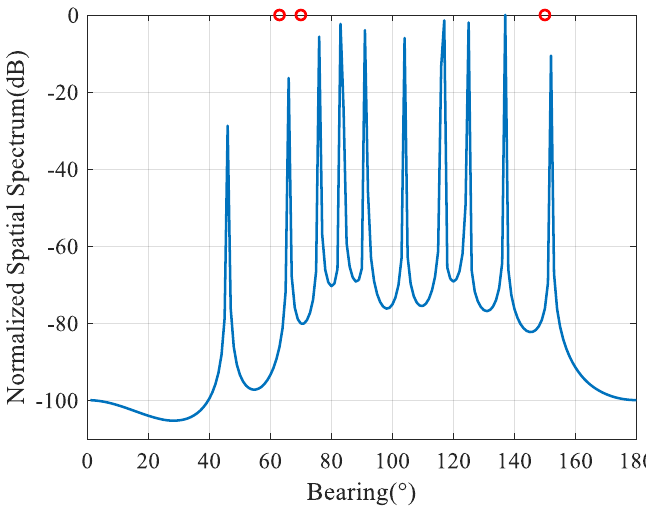
Figure 2. Spatial spectrum estimation of sparse Bayesian learning under two near-field interferences.